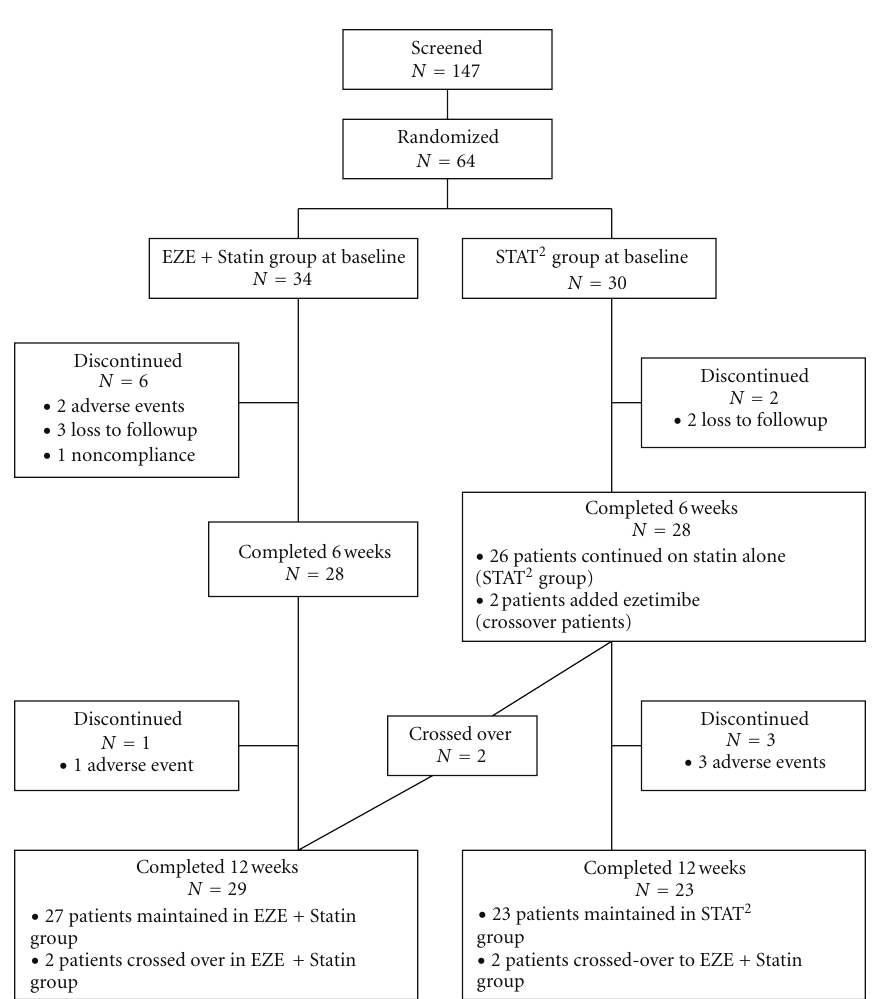
Figure 2: Enrollment, randomization, and followup of study